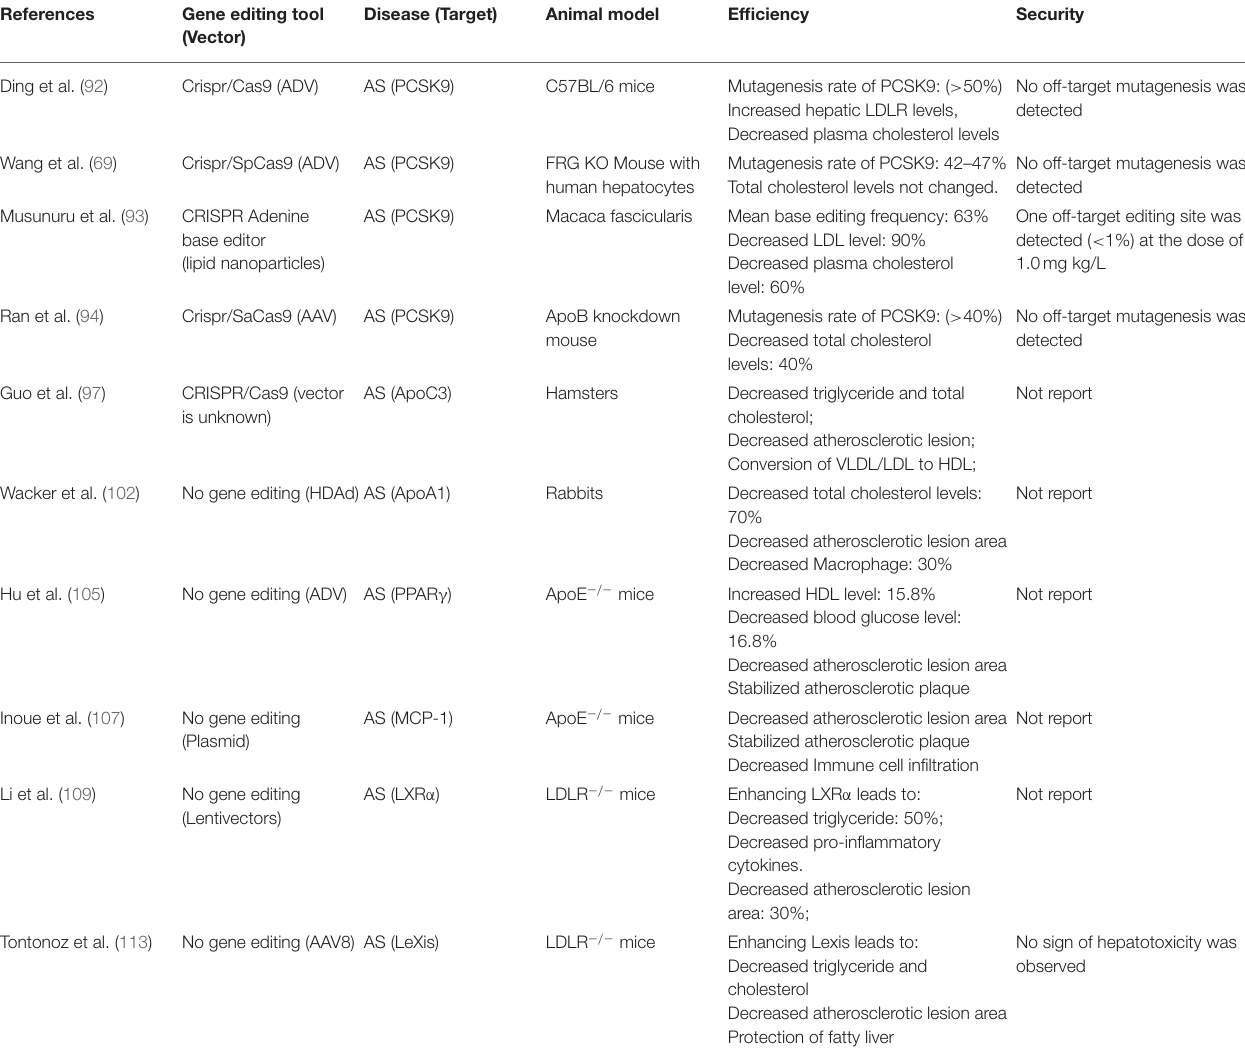
TABLE 2 | Experiments of gene therapy for